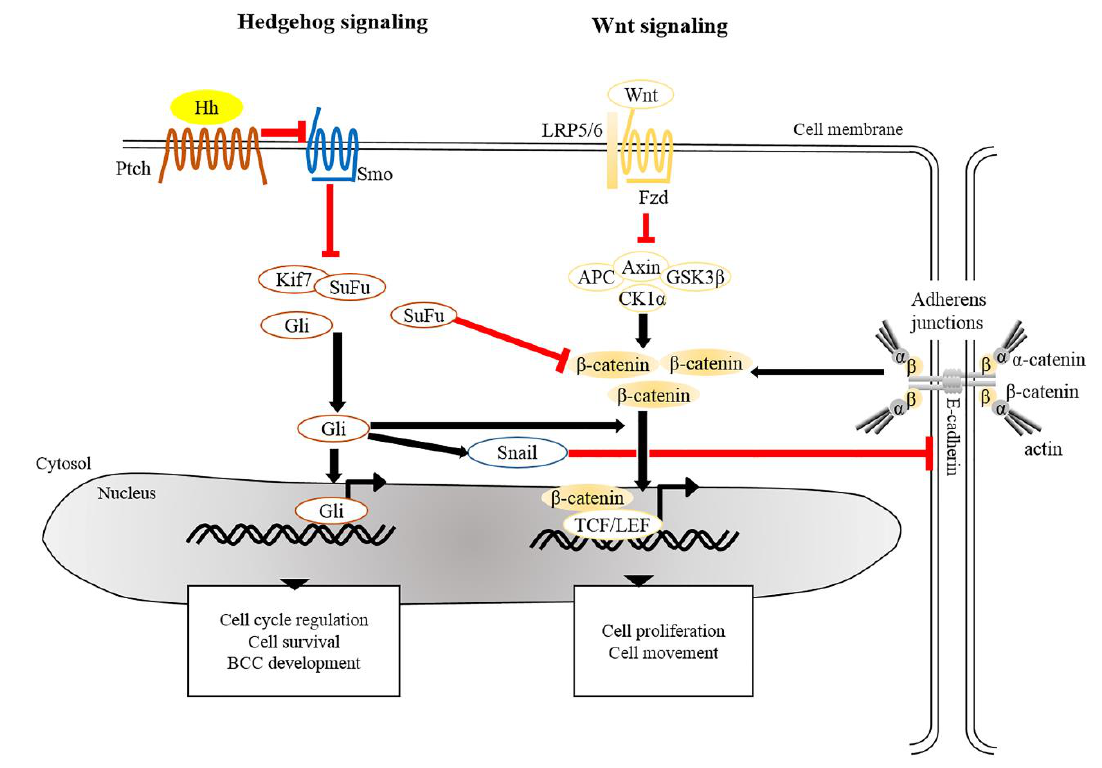
Figure 2. Crosstalk of signaling pathways in the pathogenesis of BCC. The main driver of BCC development is the dysregulation of Hedgehog signaling and Wnt / β -catenin signaling whereby the PTCH , SMO , SUFU , and CTNNB1 (a gene encoding for β -catenin) are frequently mutated in human BCCs. Mutated Ptch loses its grip on Smo that subsequently leads to its activation. Aberrant activation of Smo releases inhibition of Gli from SuFu and Kif7, thus allowing nuclear translocation of Gli. Aberrant Gli activity induces the expression of genes that regulate the cell cycle, cell survival and development of BCC. In addition, Gli induces Snail leading to the inhibition of E-cadherin, which in turn results in the accumulation of free β -catenin and its translocation to the nucleus. Alternatively, inactivation of SuFu and Kif7 leads to the accumulation and nuclear translocation of stabilized β -catenin which in turn facilitates BCC genesis. BCC, basal cell carcinoma; Gli, Glioma associated oncogenic homolog; Kif7, kinesin family member 7; Ptch, Patched; Smo, Smoothened; SuFu, Suppressor of Fused.